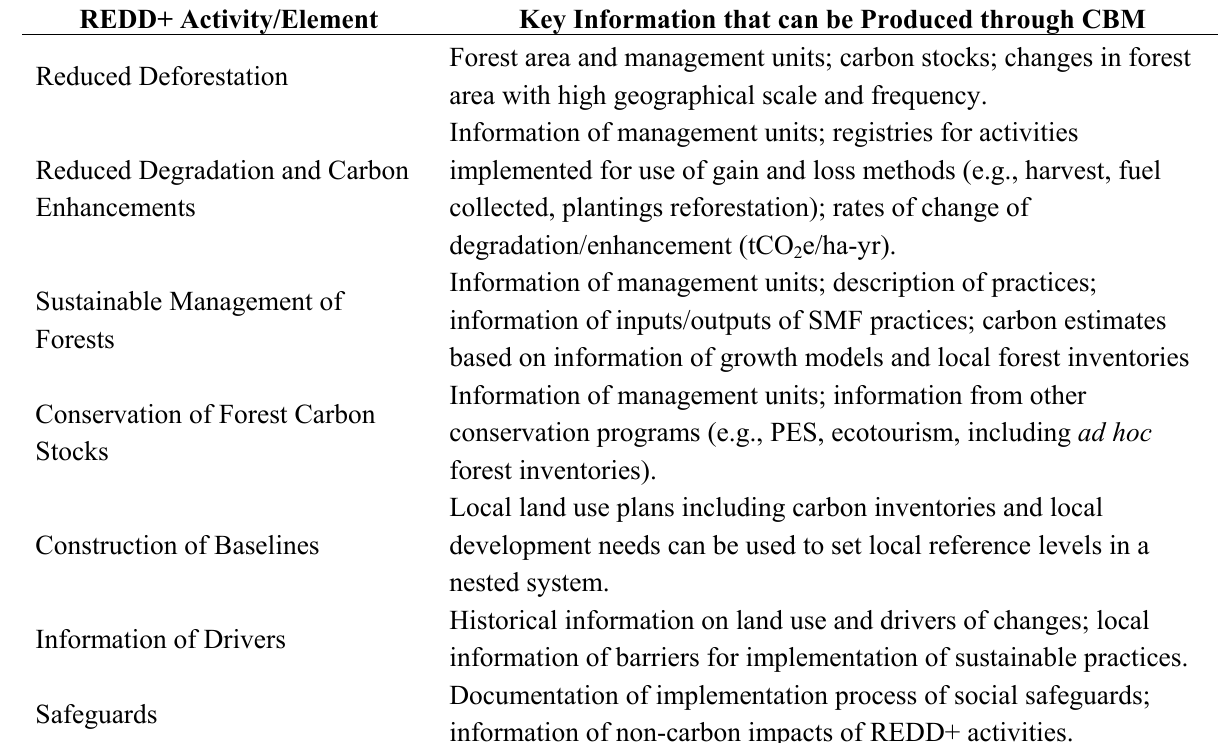
Table 3. Key information that can be produced for different REDD+ activities and elements through